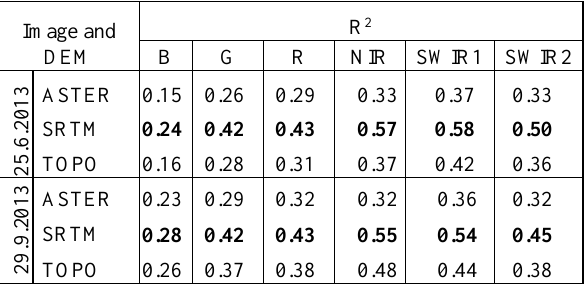
Table 4. The mean R 2 of three NDVI classes obtained from the linear regression between cos i from different DEMs and each spectral bands from the two images. Values in bold are the highest R 2